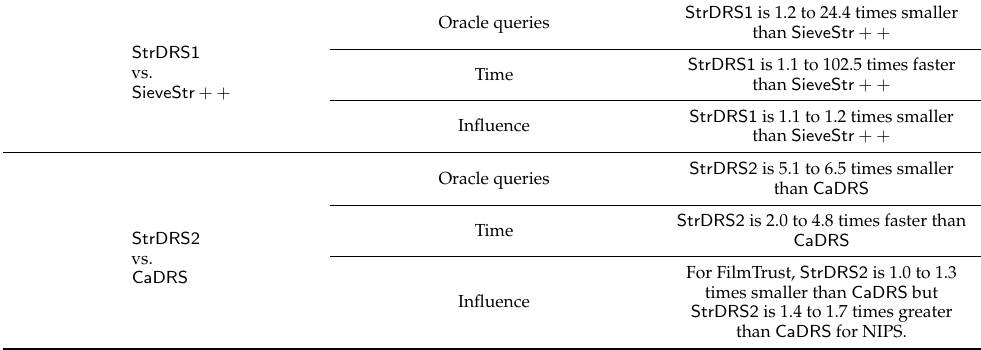
Table 5. Statistical comparison of experimental results.